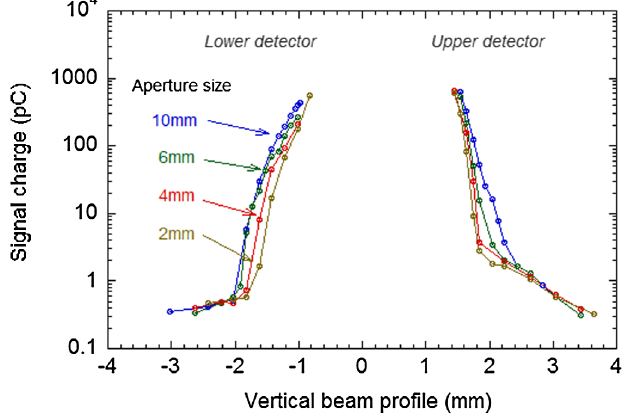
FIG. 17. Scanning measurements with various aperture size of the energy filter. The numbers are the aperture sizes of the energy filter. (The width of the spatial slit was fixed to 10